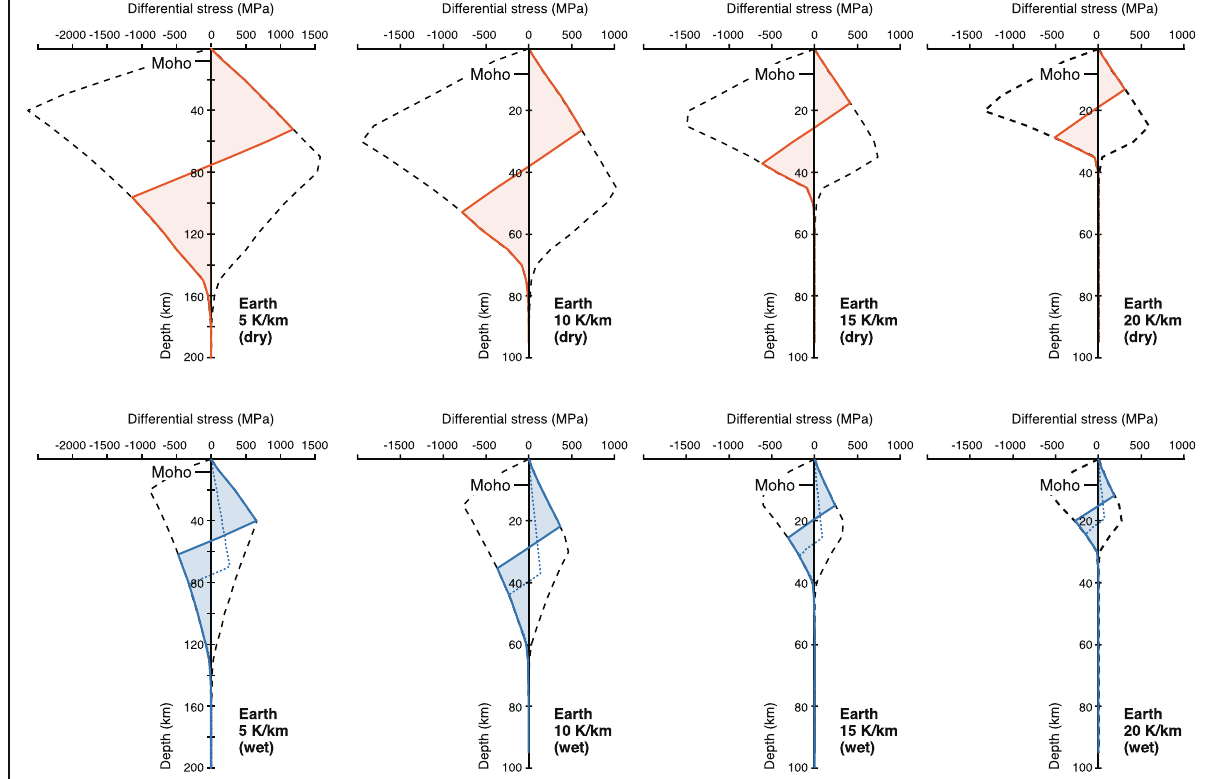
Fig. 6 Strength profiles for oceanic lithosphere of Earth with variable thermal gradients under dry (upper panel) and wet (lower panel) conditions. Dotted lines in the lower panels indicate brittle strength calculated in the presence of clay minerals. Calculation parameters are the same as those for Fig.